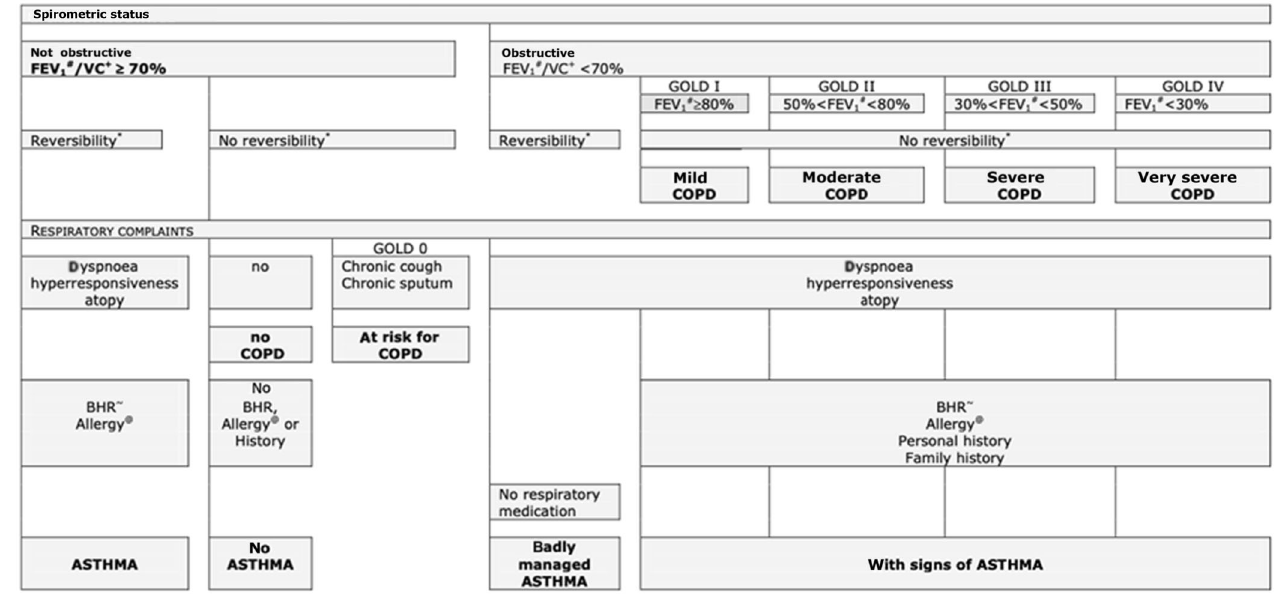
Fig. 1 Decision tree used by the chest physicians to support their assessment of chronic lung disease diagnoses based on GOLD and GINA guidelines 22 . # Postbronchodilator forced expiratory volume. + Postbronchodilator vital capacity. *12% change in FEV1 (after bronchodilation), with a change of at least 200 mL. ~ Bronchial hyperresponsiveness (positive at a provocative histamine concentration ≤ 8mg/mL). @ Skin prick